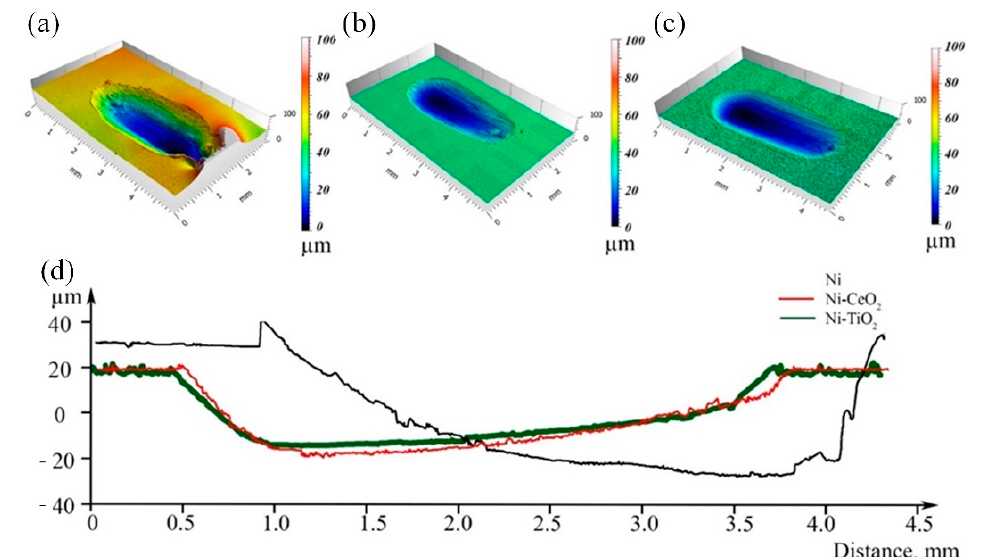
Figure 7. 3D optical surface profile images of Ni ( a ), Ni-CeO 2 ( b ), and Ni-TiO 2 ( c ) coatings after wear tests and corresponding profiles of the wear tracks ( d ).